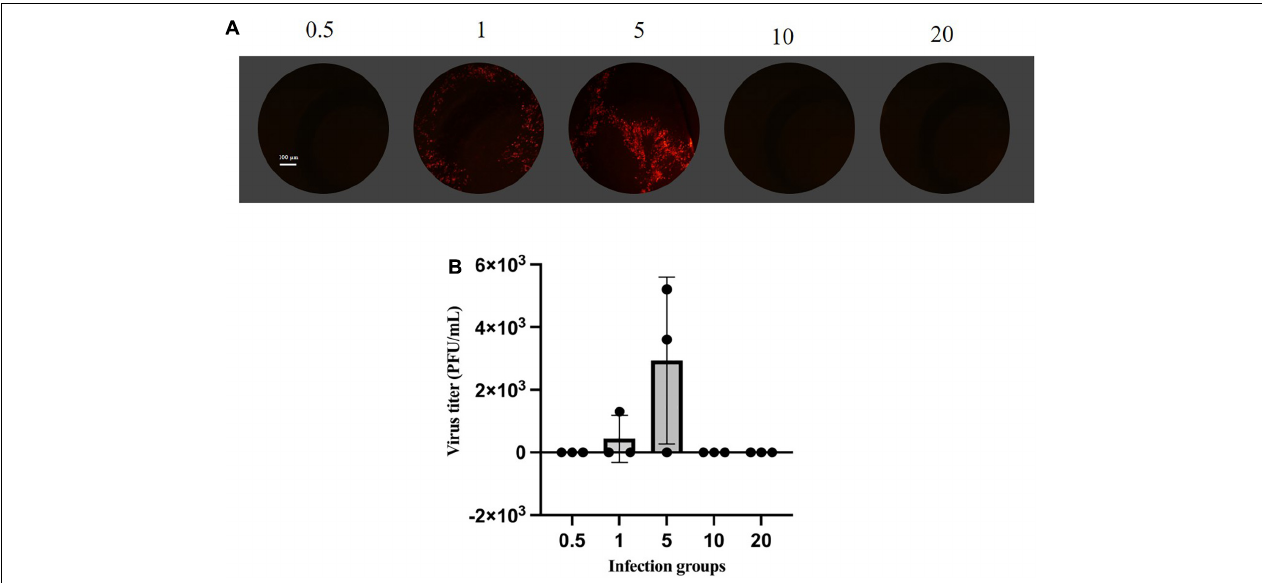
FIGURE 2 | Plaque assay based on mCherry fluorescence. (A) Monolayers of BHK-21 cells were infected with rVSVmc-p for 24–48 h. Cells were then fixed, observed, and determined by plaque assay under fluorescence microscopy. (B) Titrations of rVSVmc-p. BHK-21 cells were incubated with different groups of MOIs. The virus titers were determined by titration on BHK-21 cells.